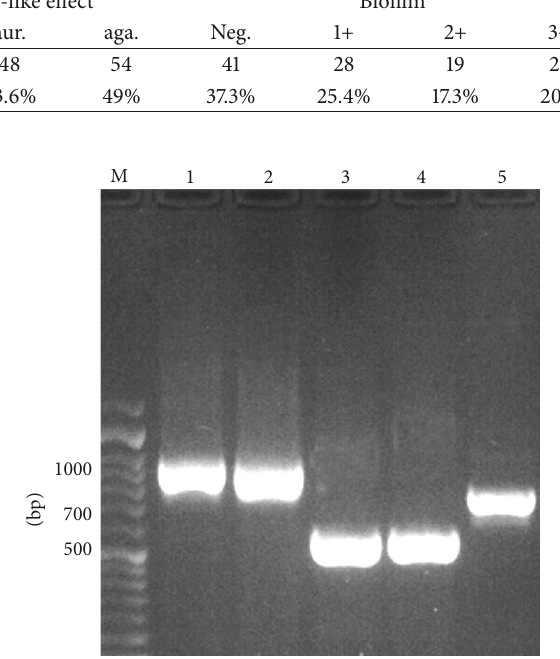
Figure 1: Agarose gel electrophoresis of HWP1 gene amplification (PCR products): C. albicans (ATCC10261) lane 1, C. albicans isolate (lanes 2), C. dubliniensis (CBS 8501) lanes 3 and 4, C. africana (IFRC707) lane 5, and molecular size markers lane M.